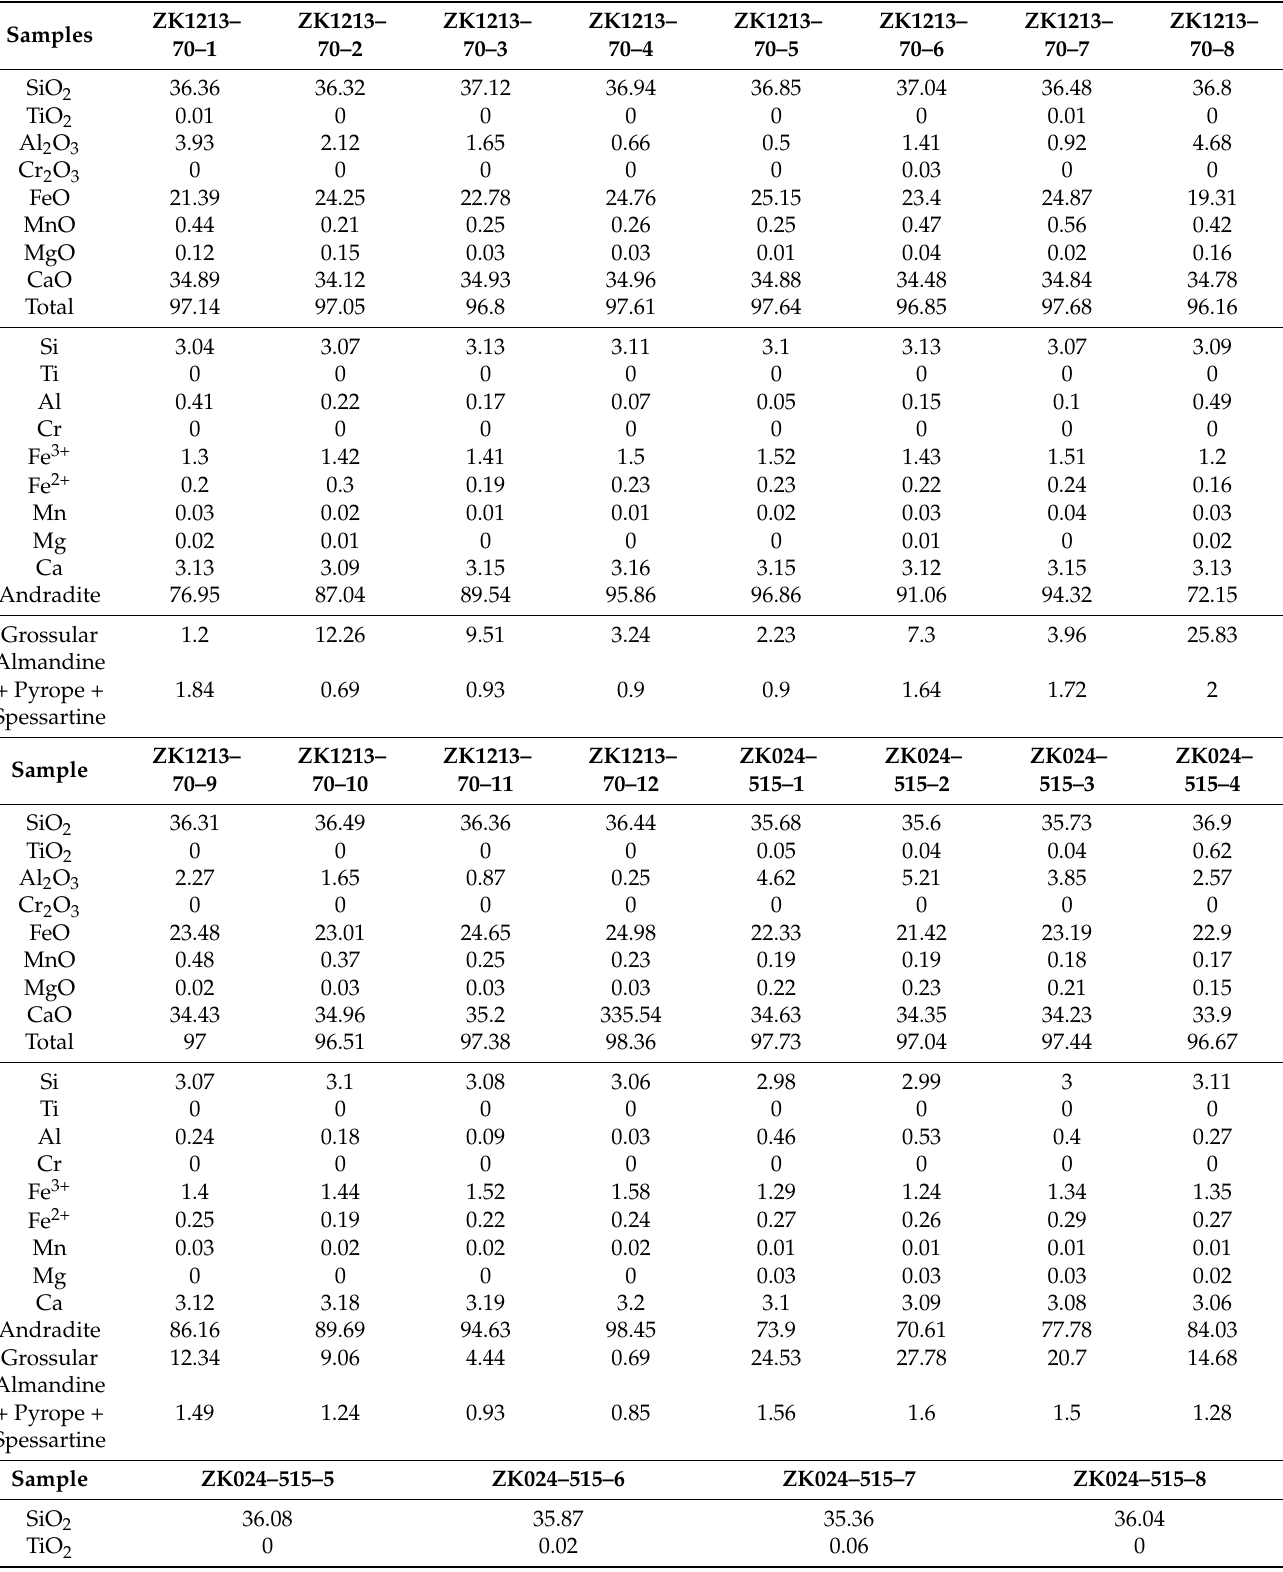
Table 3. EPMA analysis results (wt%) of the zoned